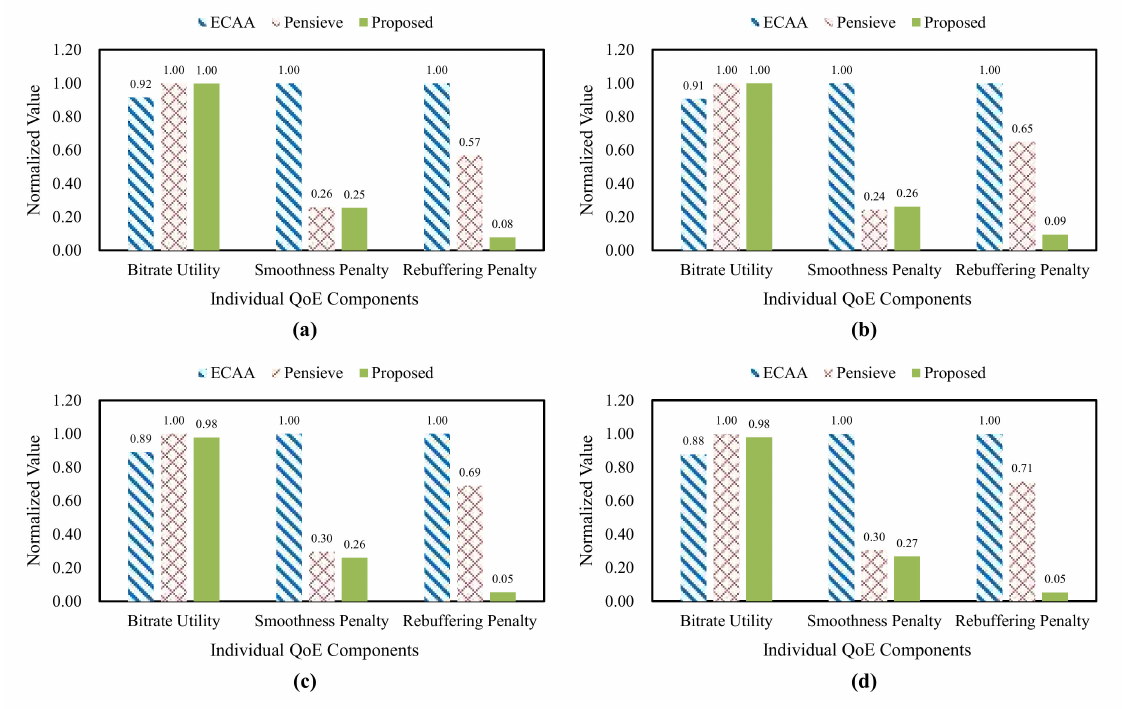
Figure 8. Comparisons of the individual QoE components according to the number of clients, ( a ) 5 clients, ( b ) 10 clients, ( c ) 15 clients, ( d ) 20